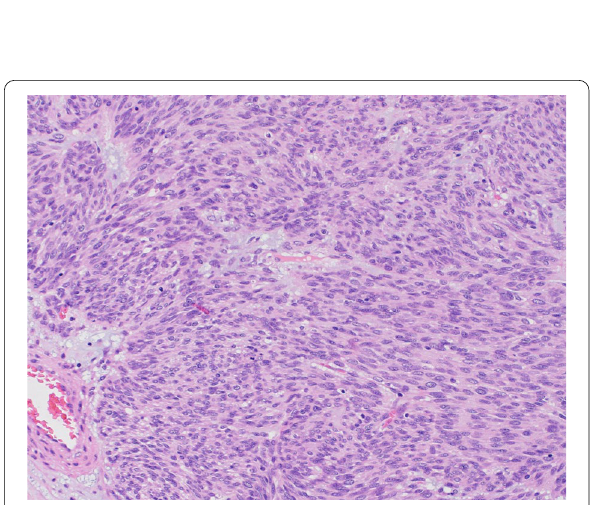
Fig. 6 Hematoxylin and eosin staining (magnification tumor growth consisting of bundles of spindle-shaped cells is seen